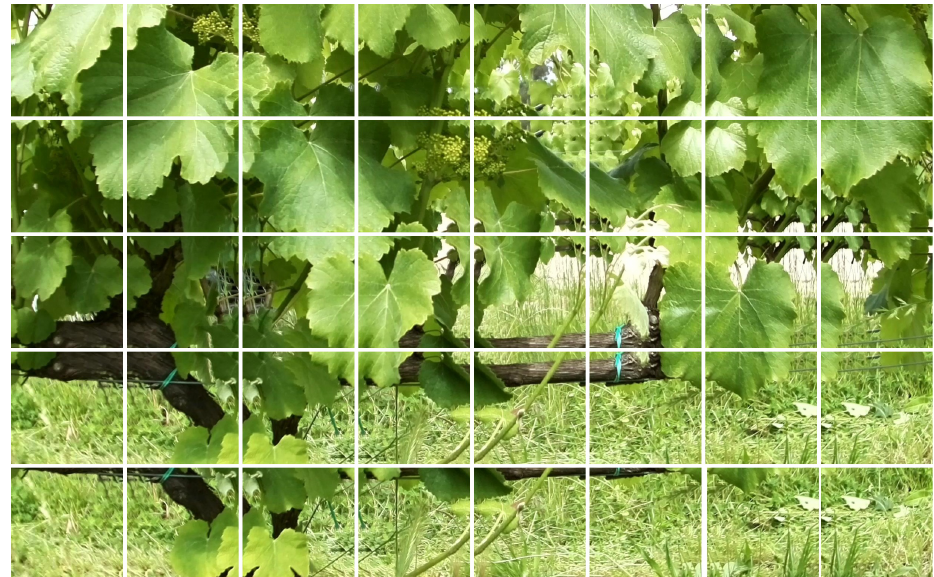
Figure 5. Split of a collected image to a 300 × 300 px resolution. The original image with a resolution of 1920 × 1080 px generated 40 split images considering an overlapping ratio of